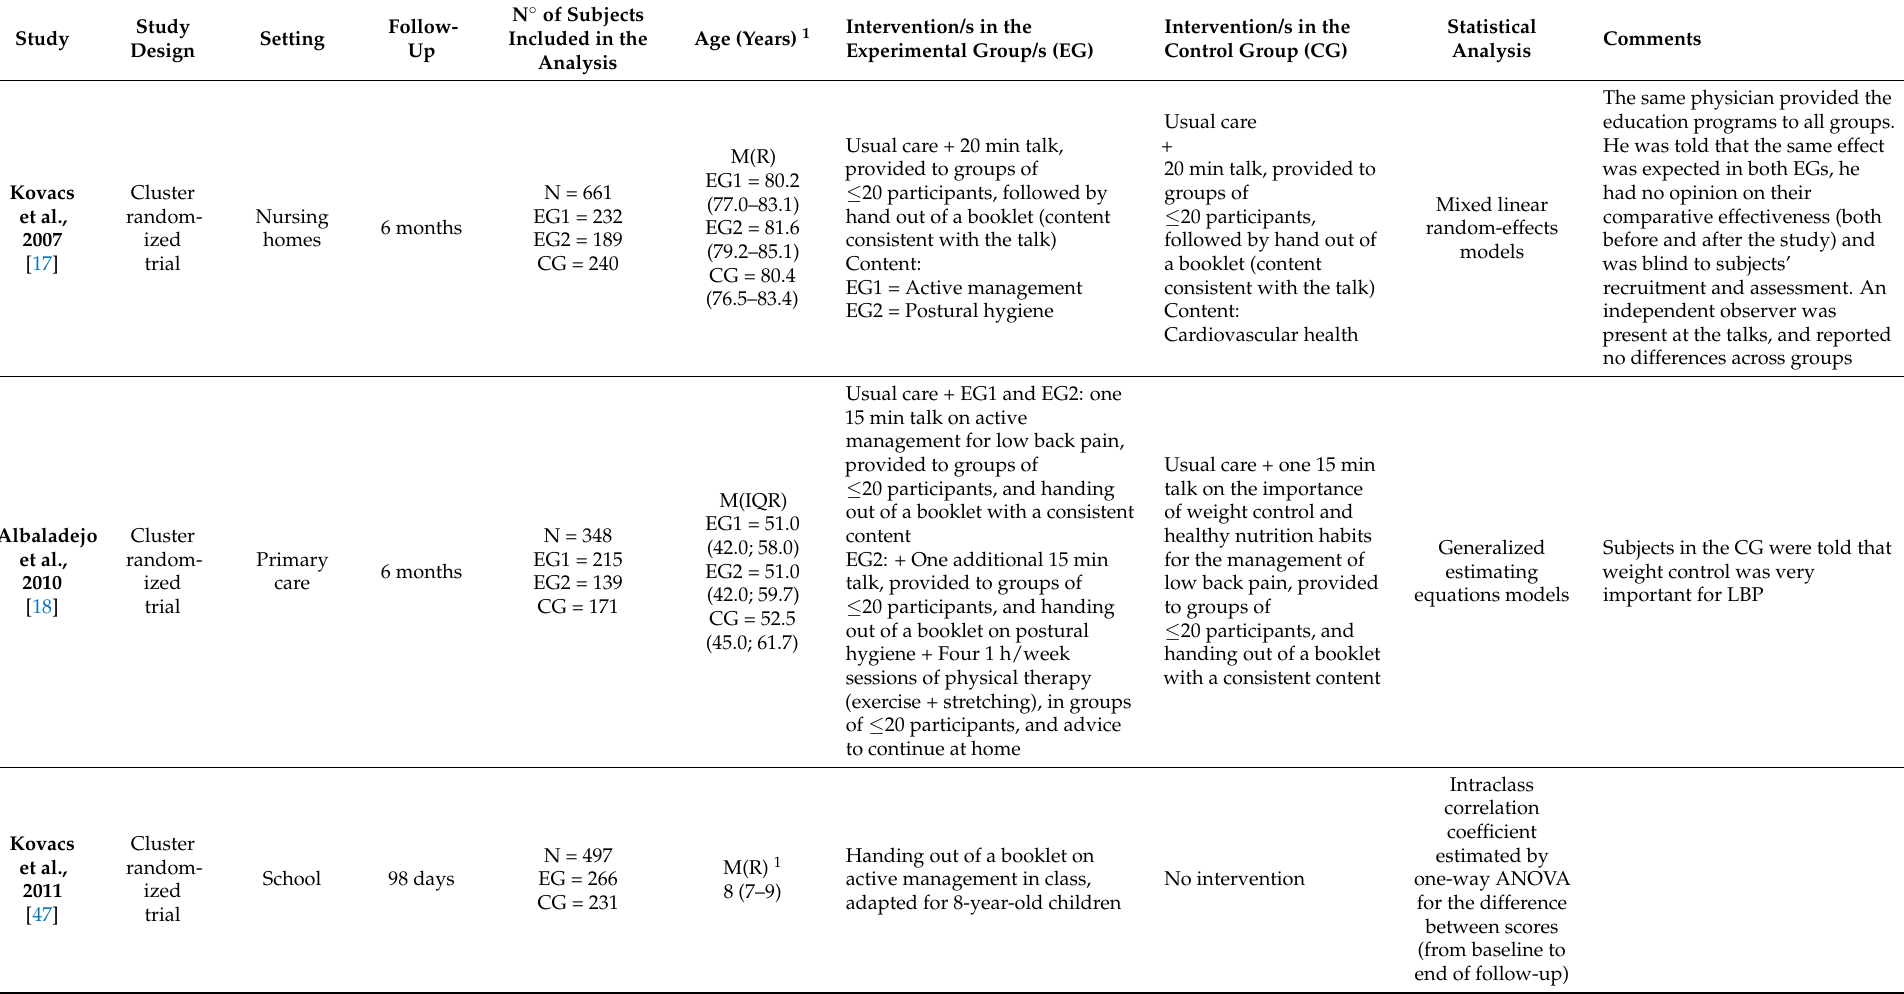
Table 1. Main Characteristics of the Studies Included in the Systematic